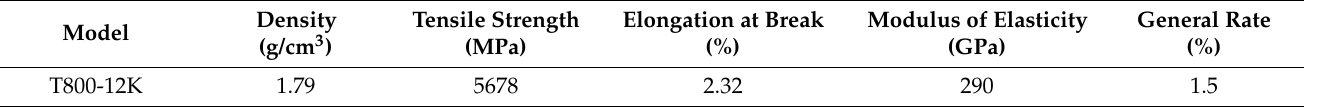
Table 1. Carbon fiber performance parameters.